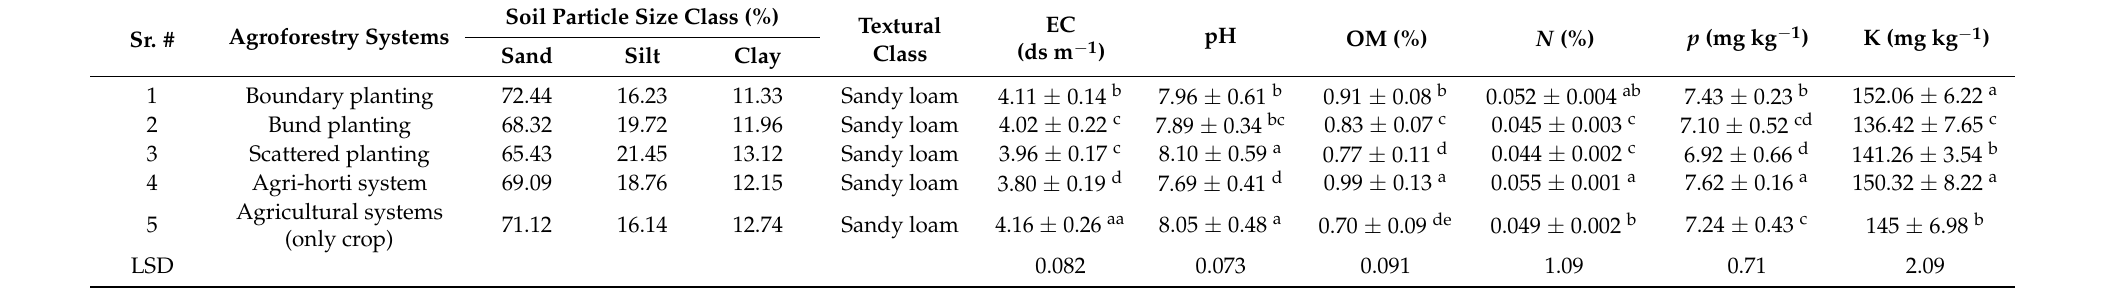
Table 1. Soil properties and a textural class of different agroforestry systems in the semi-arid region. Sr.